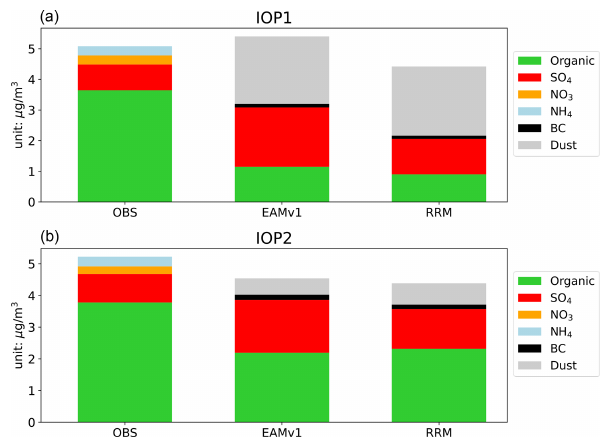
Figure 8. Bar plots of the surface average aerosol composition dur- ing HI-SCALE IOP1 (a) and IOP2 (b) . Observations are obtained from an ACSM. Dust and black carbon (BC) are not measured in the observations. NO 3 and NH 4 are not predicted in EAMv1 and